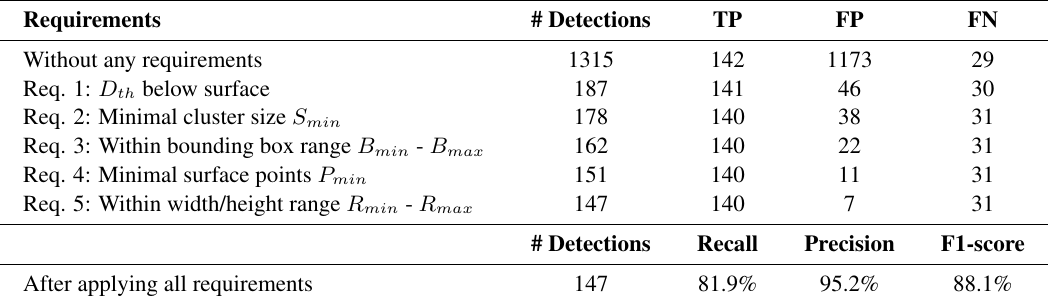
Table 2. Summary of storm drain detection results on the testing dataset with the individual influence of the different requirements on the false positive filtering and detection results after applying all requirements.